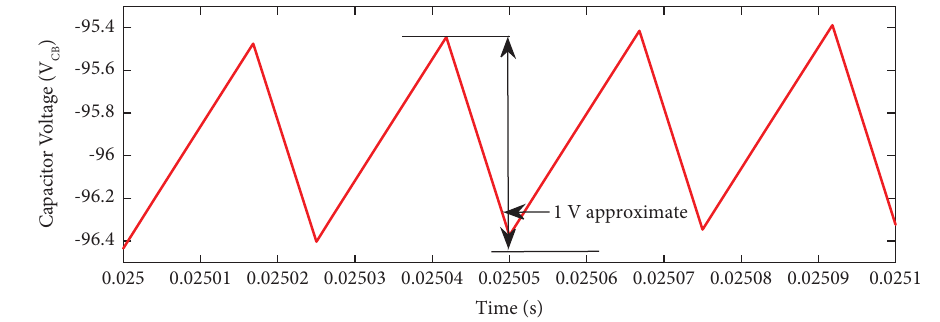
Figure 20: Simulated voltage waveform of capacitor C